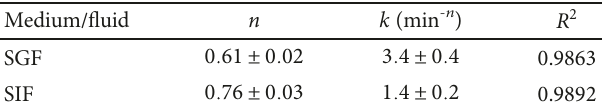
Figure 7: In vitro release pro fi les of dexamethasone from CS microparticles in di ff erent simulated fl uids: simulated gastric fl uid (SGF, pH 1.2) and simulated intestinal fl uid (SIF, pH 6.8). Table 2: Estimated values of n and k obtained from fi tting the experimental data to the Ritger-Peppas